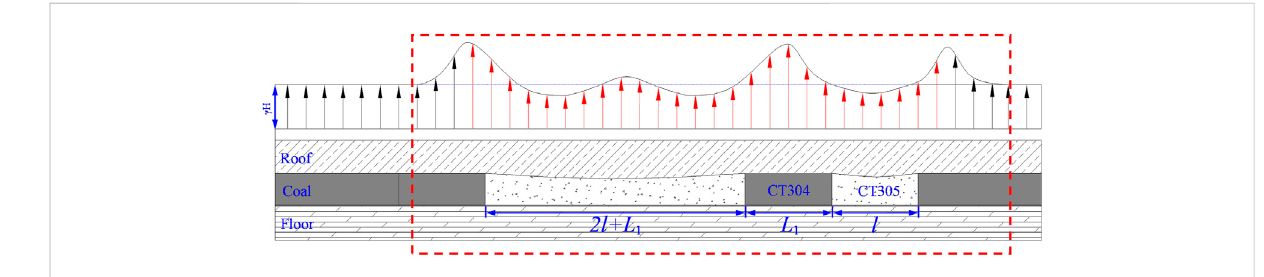
FIGURE 7 Structure 3 stress analysis